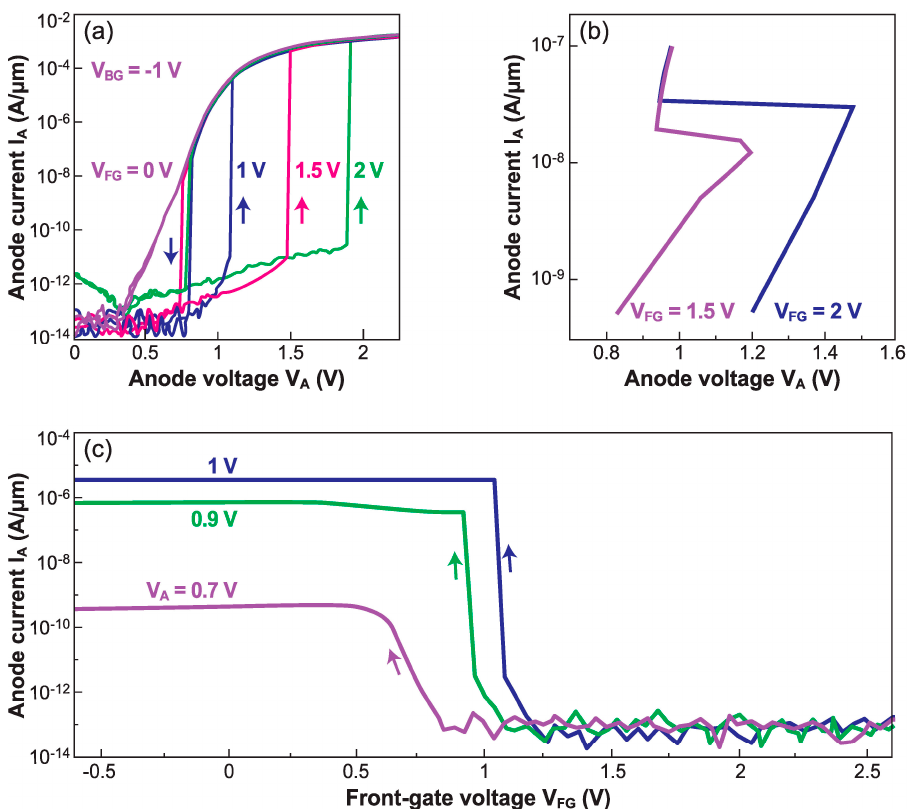
Figure 5. Experimental sharp-switching characteristics of various Z 2 –FETs in quasi-steady-state operation. Output I A -V A curves for different gate voltages, measured by ( a ) scanning the anode voltage and ( b ) forcing the anode current. ( c ) Transfer I A -V FG curves for various anode voltages V A .